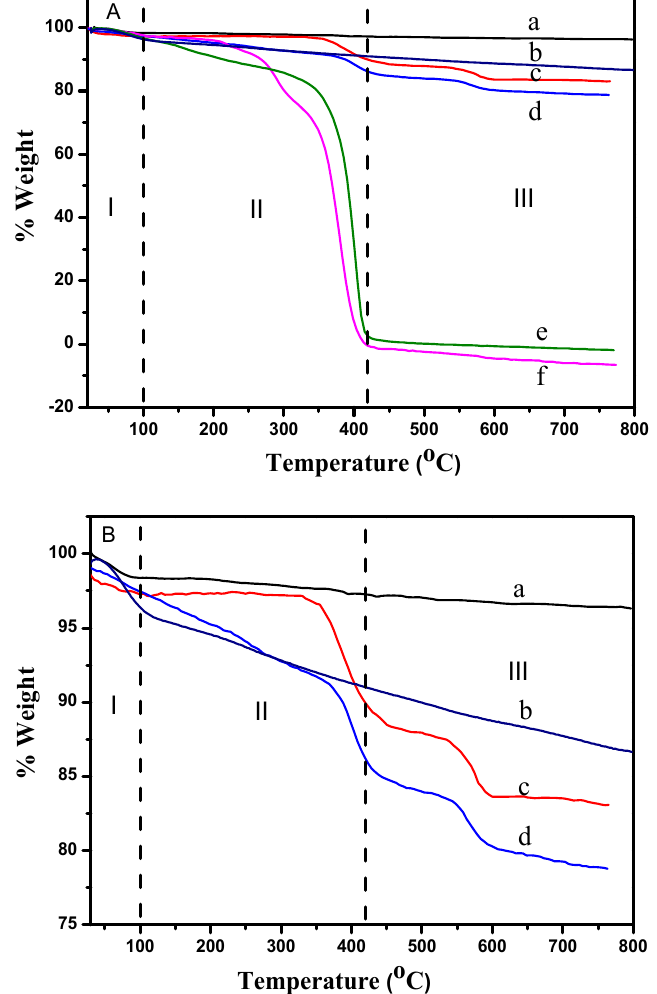
Figure 6. ( A ) TG curves of (a) hollow spheres, (b) HS-Br, (c) HS- g -PMMA, (d) HS- g -PMMA- b -PNIPAM, (e) pure PMMA and (f) pure PNIPAM. ( B ) Magnified TG curves of (a) hollow spheres, (b) HS-Br, (c) HS- g -PMMA, and (d) HS- g -PMMA- b -PNIPAM.